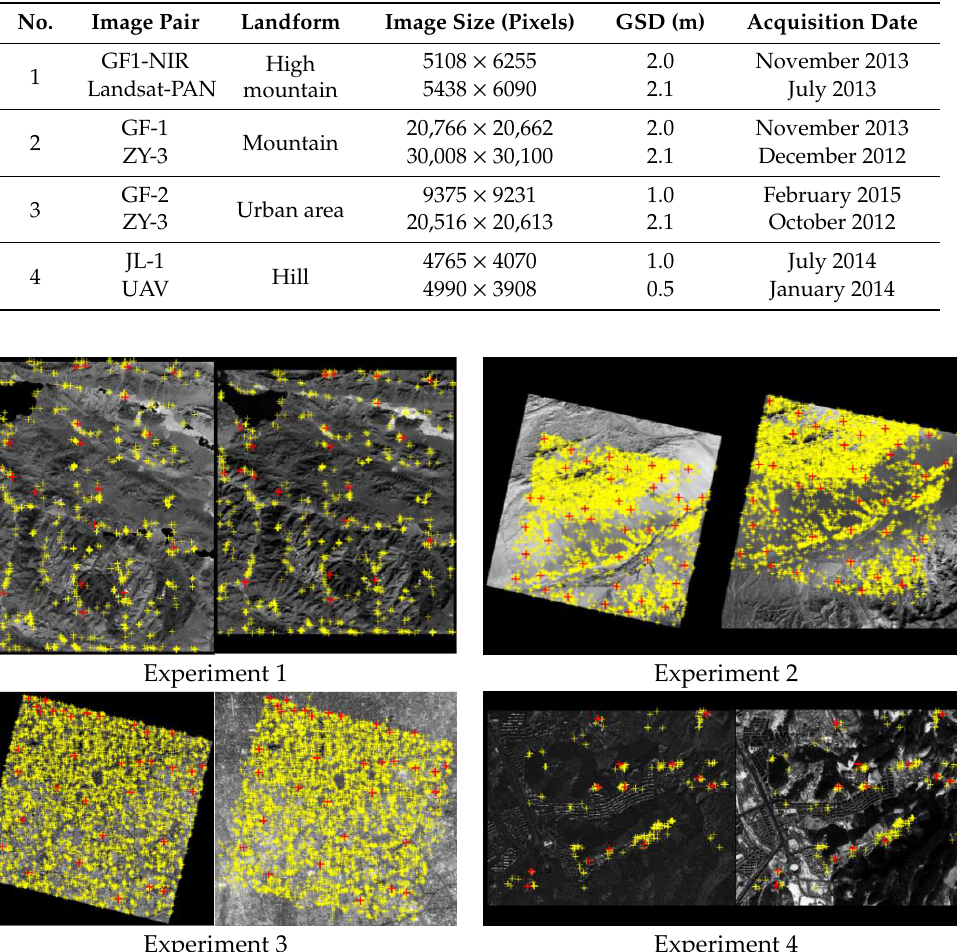
Table 2. Parameters of experimental complete image pairs.